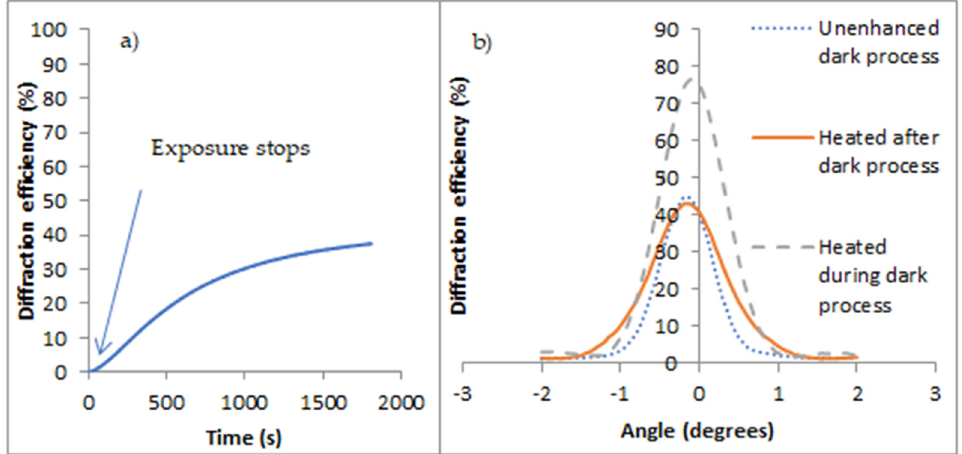
Figure 9. ( a ) Dark process growth curve of grating recorded using 10 s exposure, 476 nm, 2.5 mW/cm 2 total recording intensity; ( b ) Bragg curves of the grating treated by heat after the dark process had completed (solid), the grating heated during the dark process (dashed) and the grating with no heat treatment (dotted). Recorded at 532 nm, 1000 L/mm, 20 mW/cm 2 , heat treated at 90 ◦